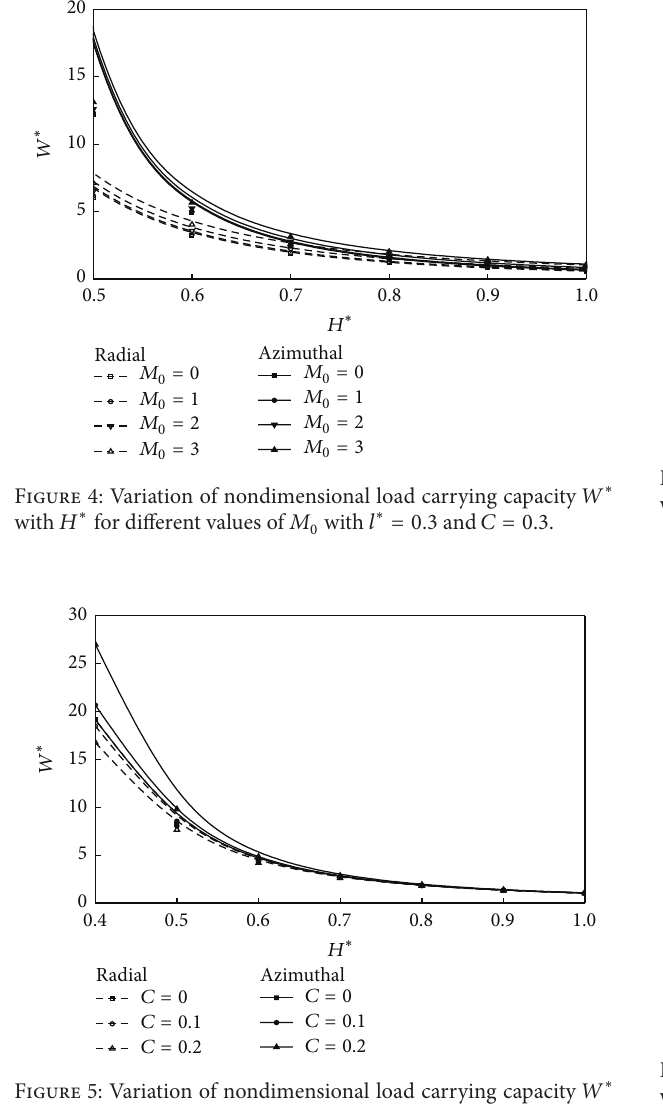
𝐶 with 𝑀 = 3 and 𝑙 ∗ = 0.3 0